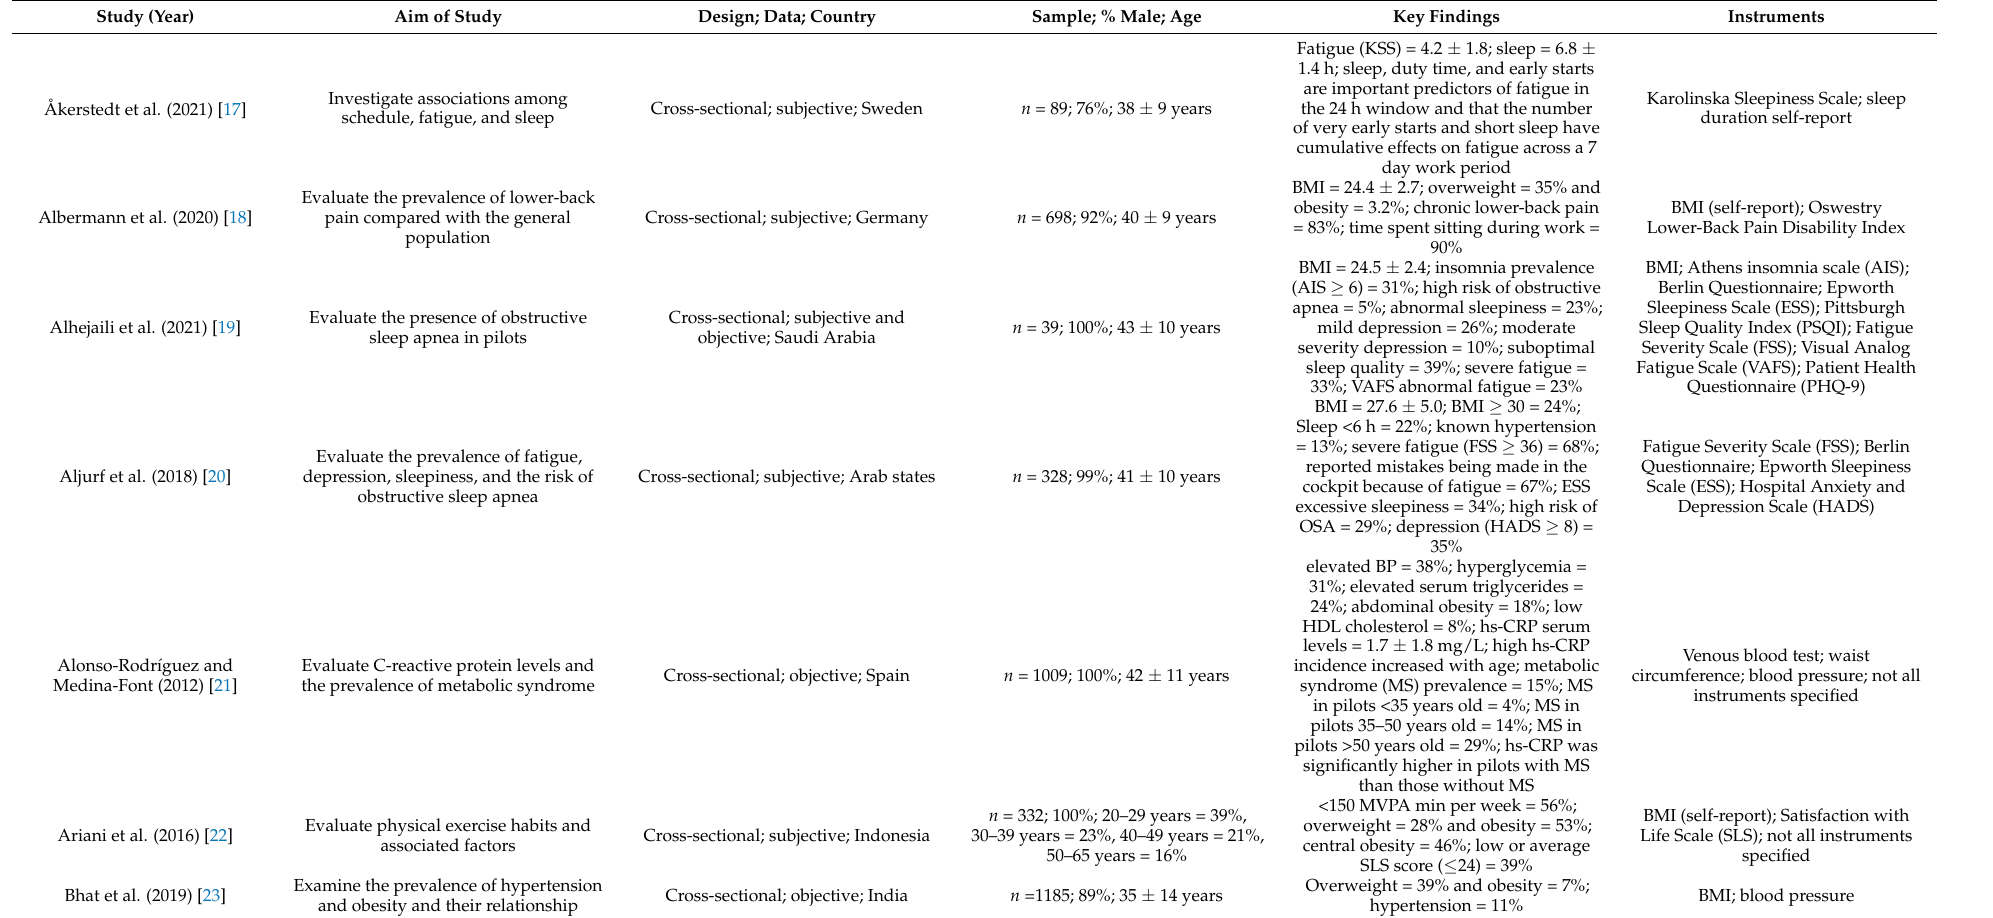
Table A1. Summary of characteristics of studies that investigated cardiometabolic health risk parameters among airline